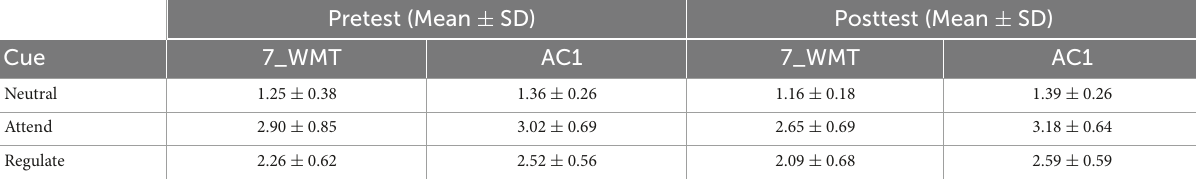
TABLE 1 The emotional reports for the neutral, attend, and regulate conditions in Experiment